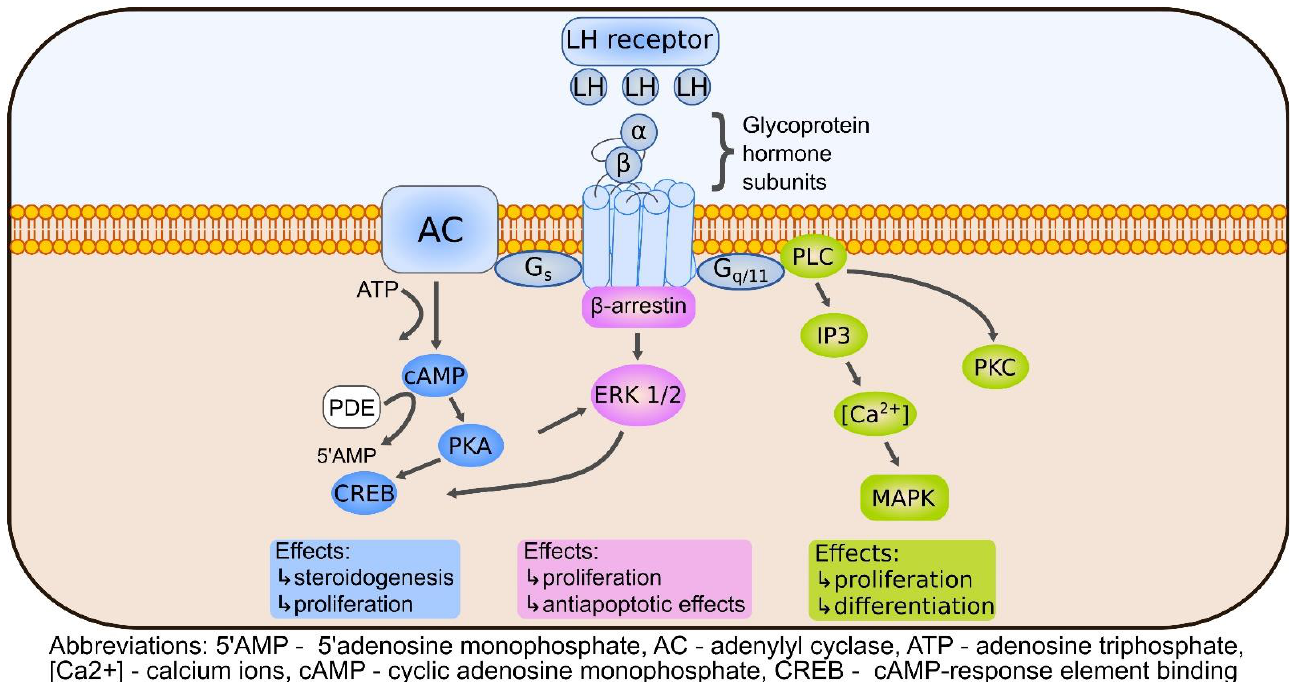
Figure 2. LH signaling. The binding of LH to a specific receptor (LHR) evokes its effects through G proteins (Gs and Gq/11) and β -arrestin. Activated adenylate cyclase (AC) increases the intracellular concentration of cAMP. PDE opposes the effects of adenylate cyclase by hydrolyzing cAMP. cAMP/PKA/CREB activates steroidogenic signals and proliferation. Gq/11 protein induces PLC/IP3/MAPK and/or PLC/PKC pathways stimulating cellular proliferation and differentiation. β -arrestin stimulates ERK1/2, and its action regulates proliferation and inhibits apoptosis.